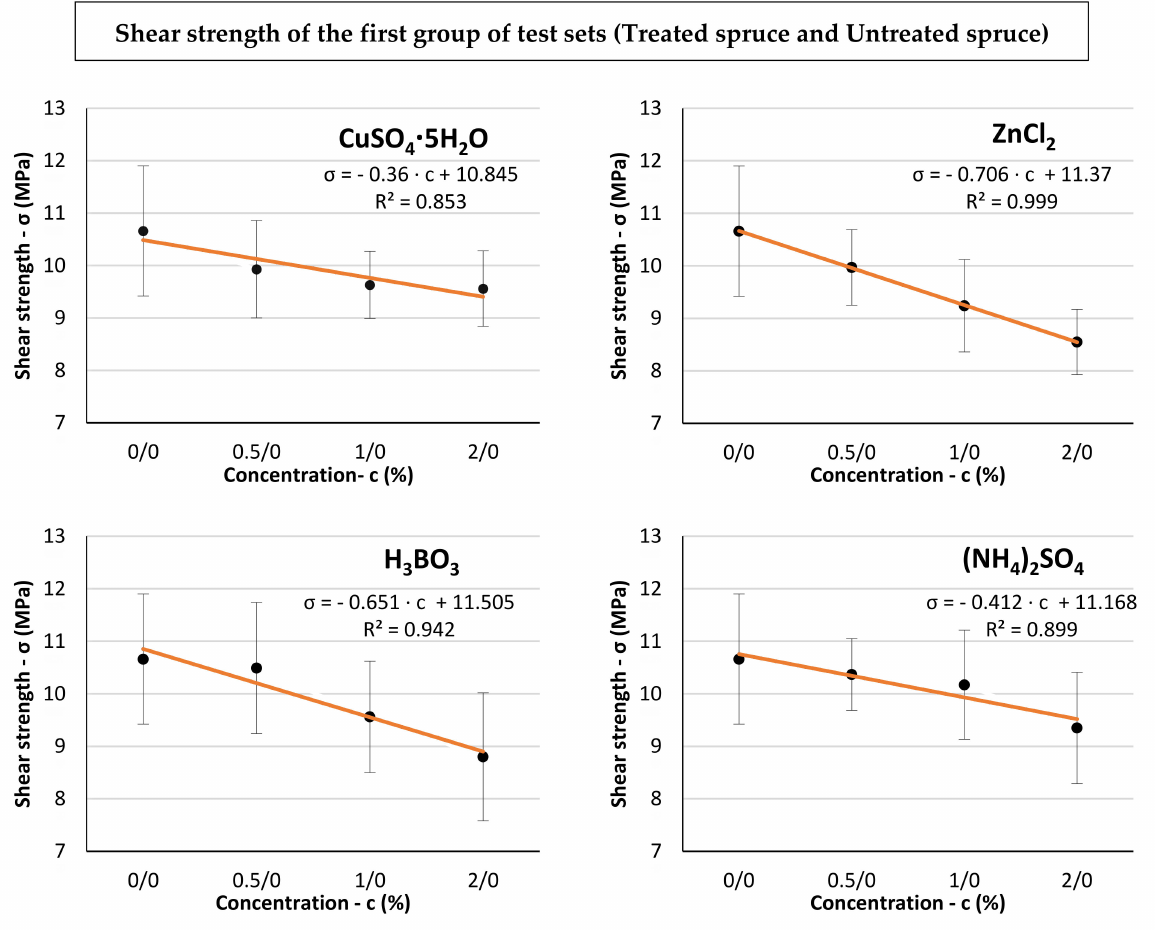
Figure 3. Linear dependencies between the shear strength of glued joints ( σ ) and the concentration of a preservative (c) in the first group of test sets “Treated spruce and Untreated